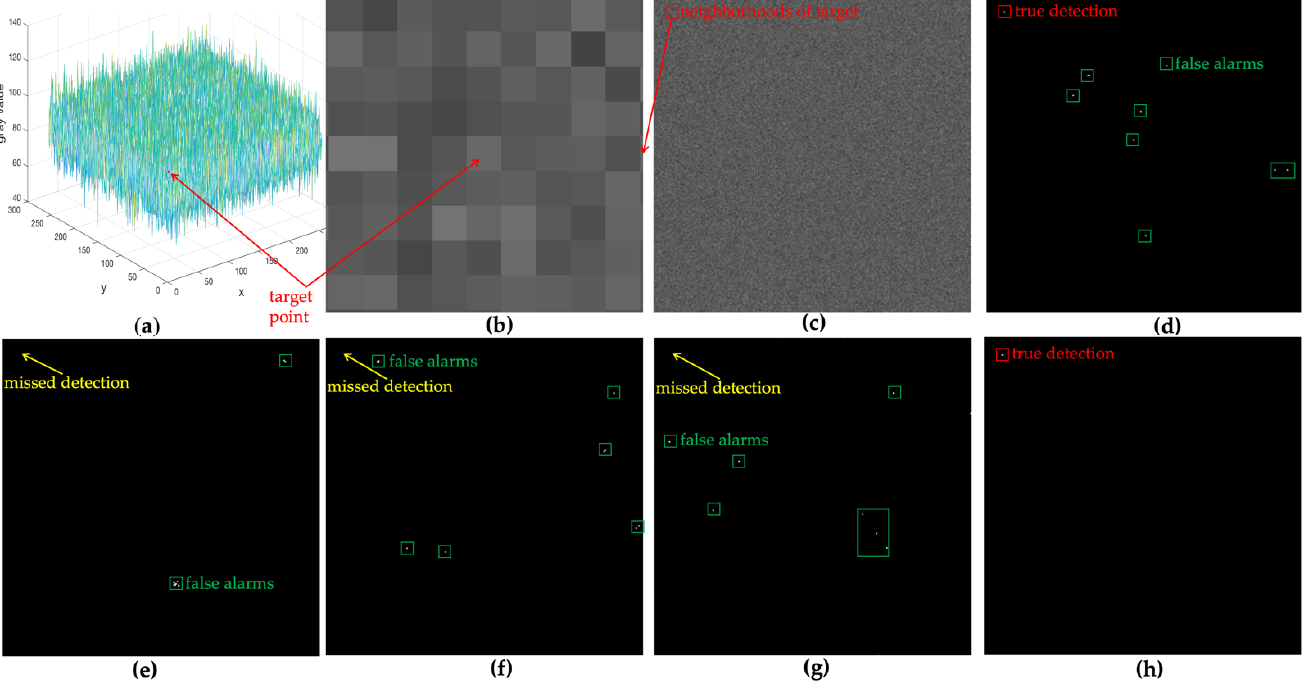
Figure 11. Detection results of the different methods. ( a ) 3-D display of the input image; ( b ) 9 × 9 neighborhoods of the target; ( c ) input image, SCR is 1.5; ( d – g ) are CFAR segmentation maps of